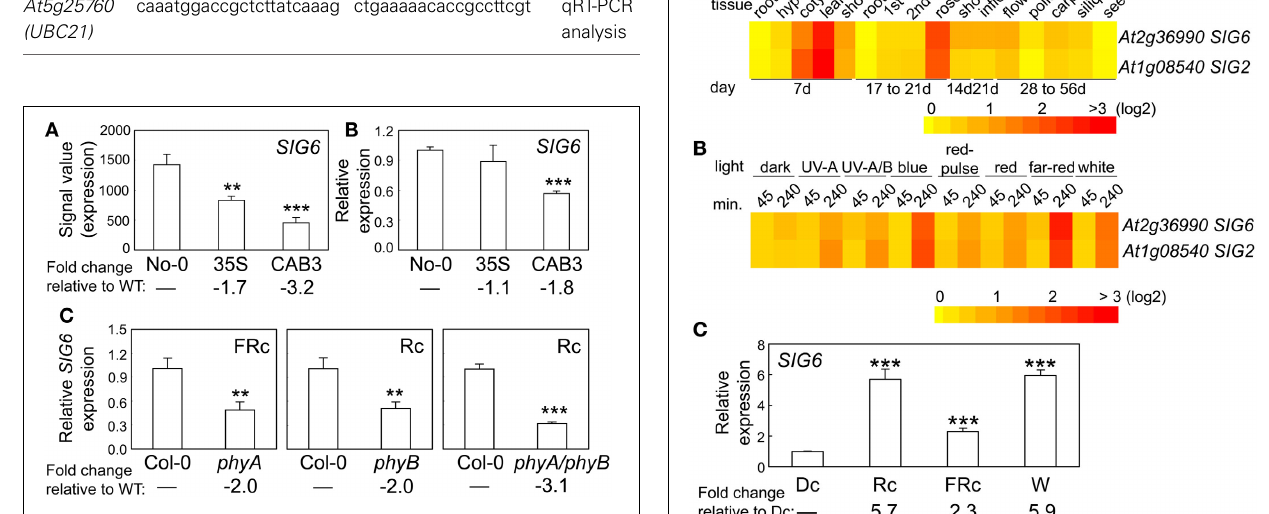
FIGURE 2 | Expression of SIG6 in different tissues and light conditions. (A) Heat map showing the expression of SIG6 in different tissues indicating mean-normalized values of Col-0 WT from AtGenExpress expression library (www.weigelworld.org) and BAR Heatmapper Plus (bar.utoronto.ca). (B) Heat map showing the expression of SIG6 in different light conditions for aerial parts (hypocotyl and cotyledons) of 4-days-old Col-0 WT seedlings grown on MS medium treated with different light for either 45 or 240min. (C) qRT-PCR analysis of SIG6 expression in Col-0 WT under dark (Dc), Rc, FRc, or white (W). Relative SIG6 expression level compared to UBC21 is shown ( ± SD , n = 3). Statistics: Unpaired, two-tailed Student’s t -test comparing different growth conditions ∗∗∗ p < 0 .